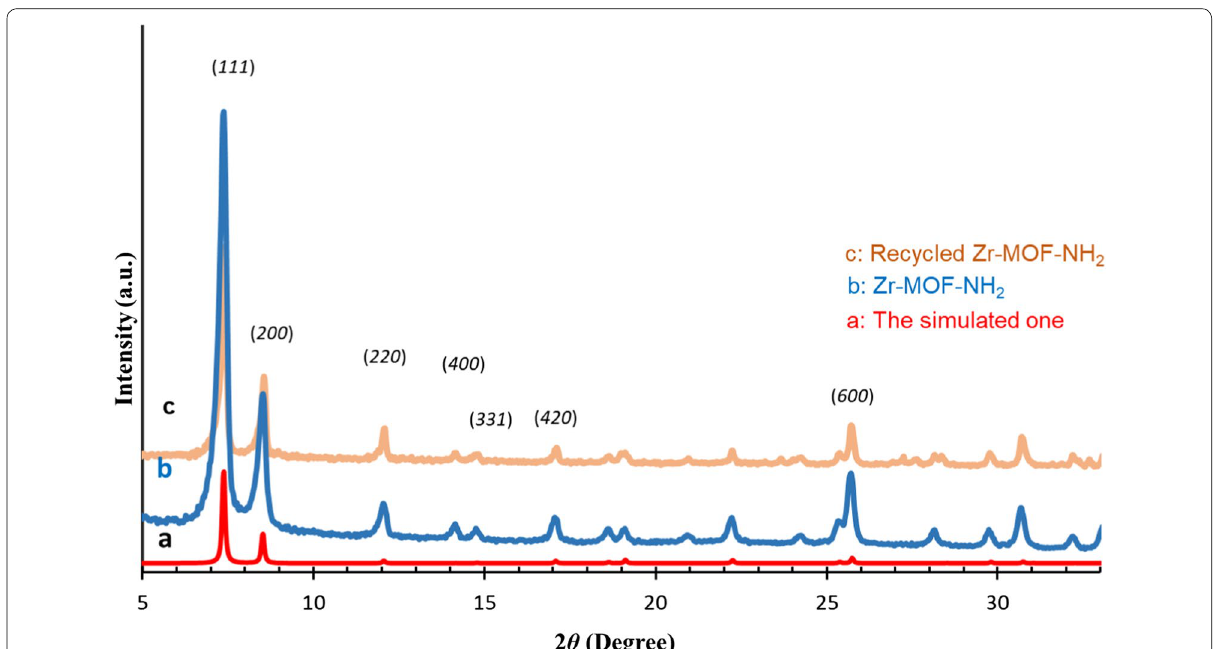
Fig. 3 PXRD patterns of a the simulated Zr-MOF-NH 2 ; b as-synthesized; and c the recycled Zr-MOF-NH 2